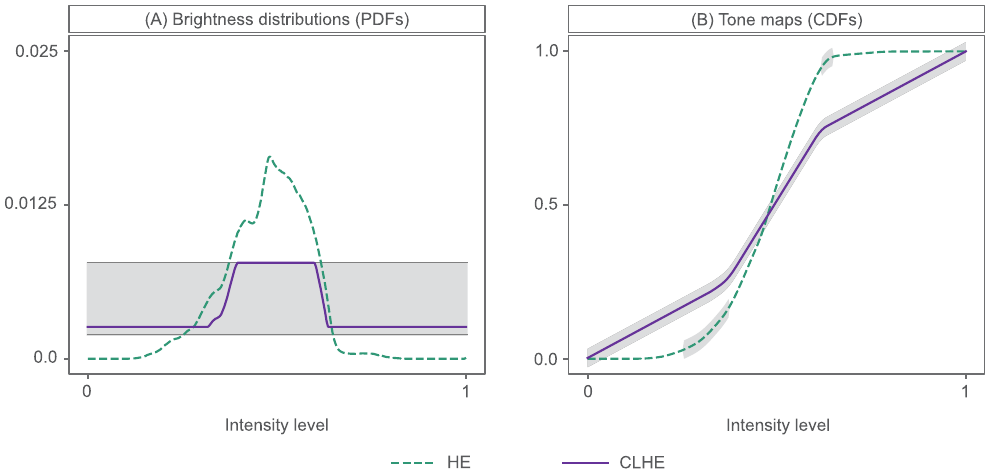
Figure 3. Image enhancement example: ( A ) Unenhanced (original), ( B ) HE and ( C ) CLHE.